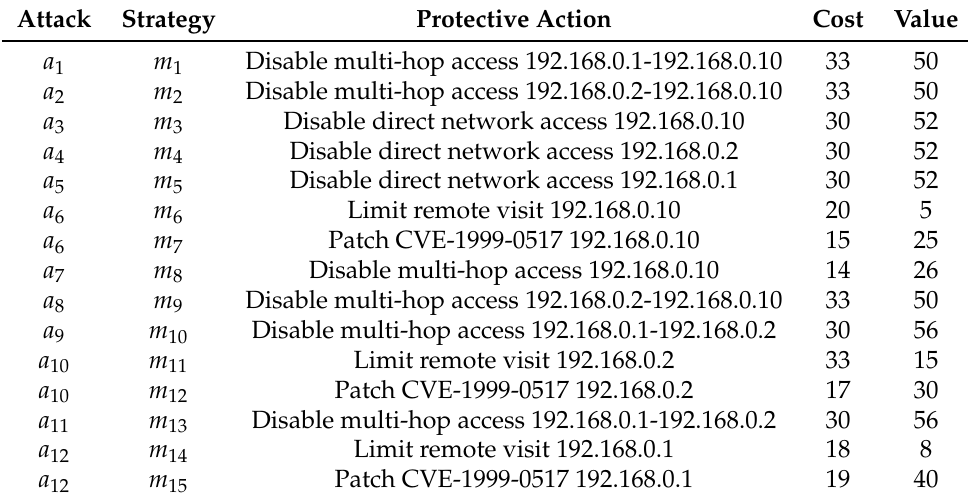
Table 7. Protection costs and protection benefits.